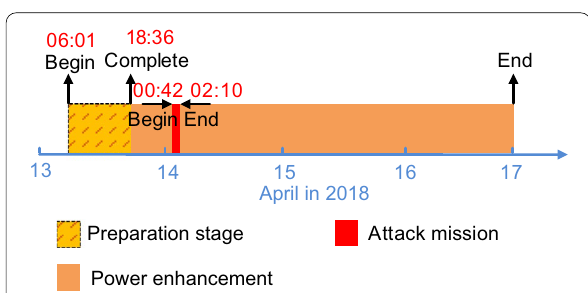
Fig. 2 The relation of loss in tracking C/N 0 vs the C/N 0 of L1P. Loss of tracking C/N 0 drops with the increasement of L1P C/N 0 because there will be fewer bit error when L1P C/N 0 increases